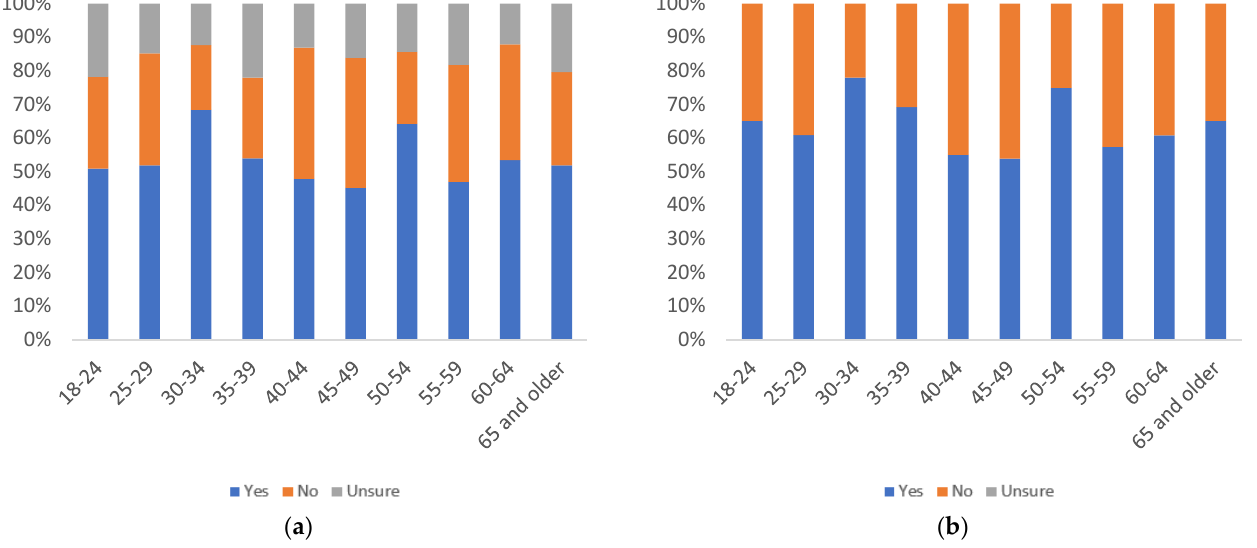
Figure 11. Label use, by age group: ( a ) with uncertain respondents (left) and ( b ) without uncertain respondents (right).